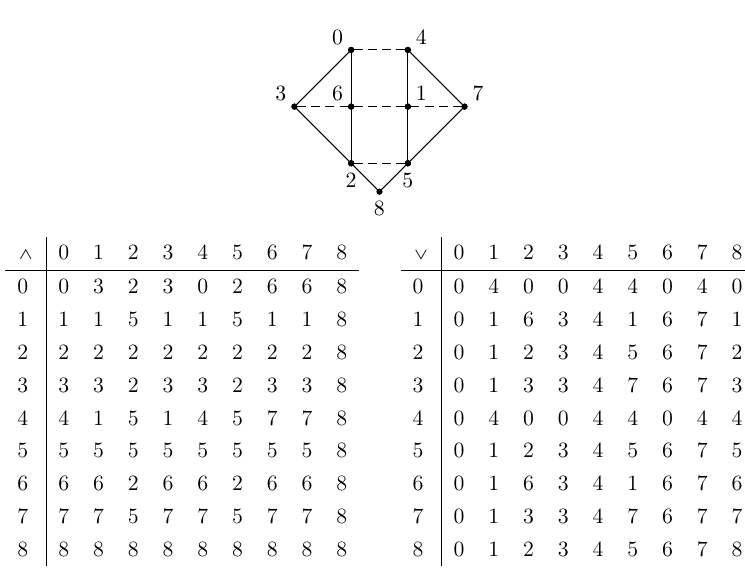
Fig. 3. The admissible Hasse diagram of another left-handed non categorical skew lattice for which φ 2 , 8 ˆ p φ 3 , 2 ˆ φ 0 , 6 q ‰ p φ 2 , 8 ˆ φ 3 , 2 q ˆ φ 0 , 6